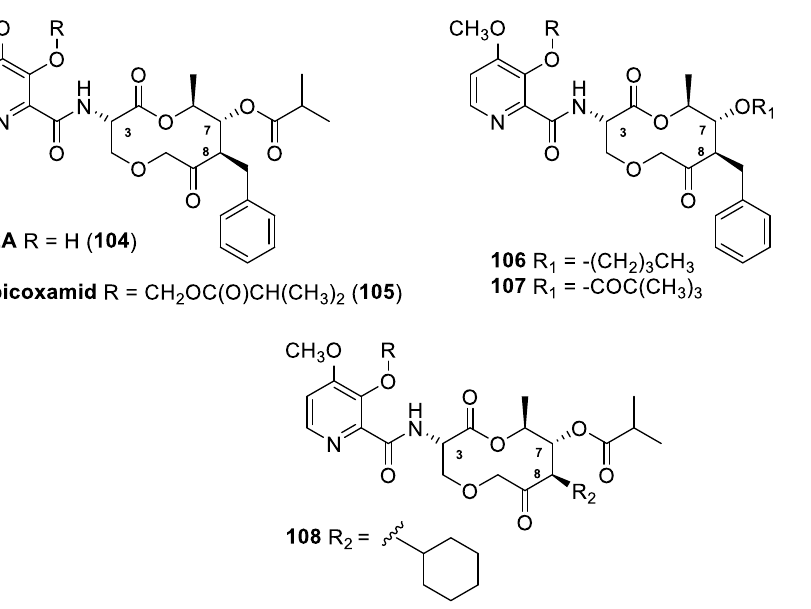
Figure 21. Structure of natural picolinamide UK-2A ( 104 ), of fenpicoxamid ( 105 ), and structures of representative analogs ( 106 – 108 ). Table 12. Comparative target site and in vitro antifungal activities of UK-2A and representative compounds 106 – 108 from References [61–63].